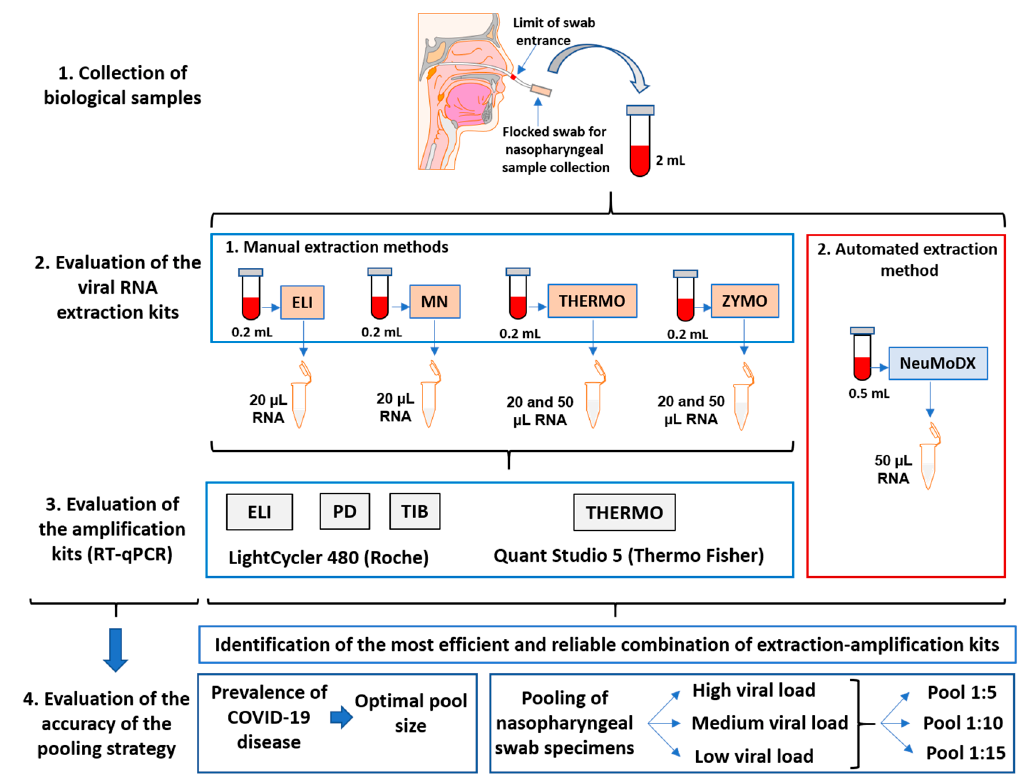
Figure 1. The workflow for large ‐ scale testing of SARS ‐ CoV ‐ 2 coronavirus by RT ‐ qPCR using four manual methods for RNA extraction and PCR assessment, two PCR devices, as well as an automated flux for SARS ‐ CoV ‐ 2 detection. The symbols for extraction and PCR amplification kits are described in the Materials and Methods section.